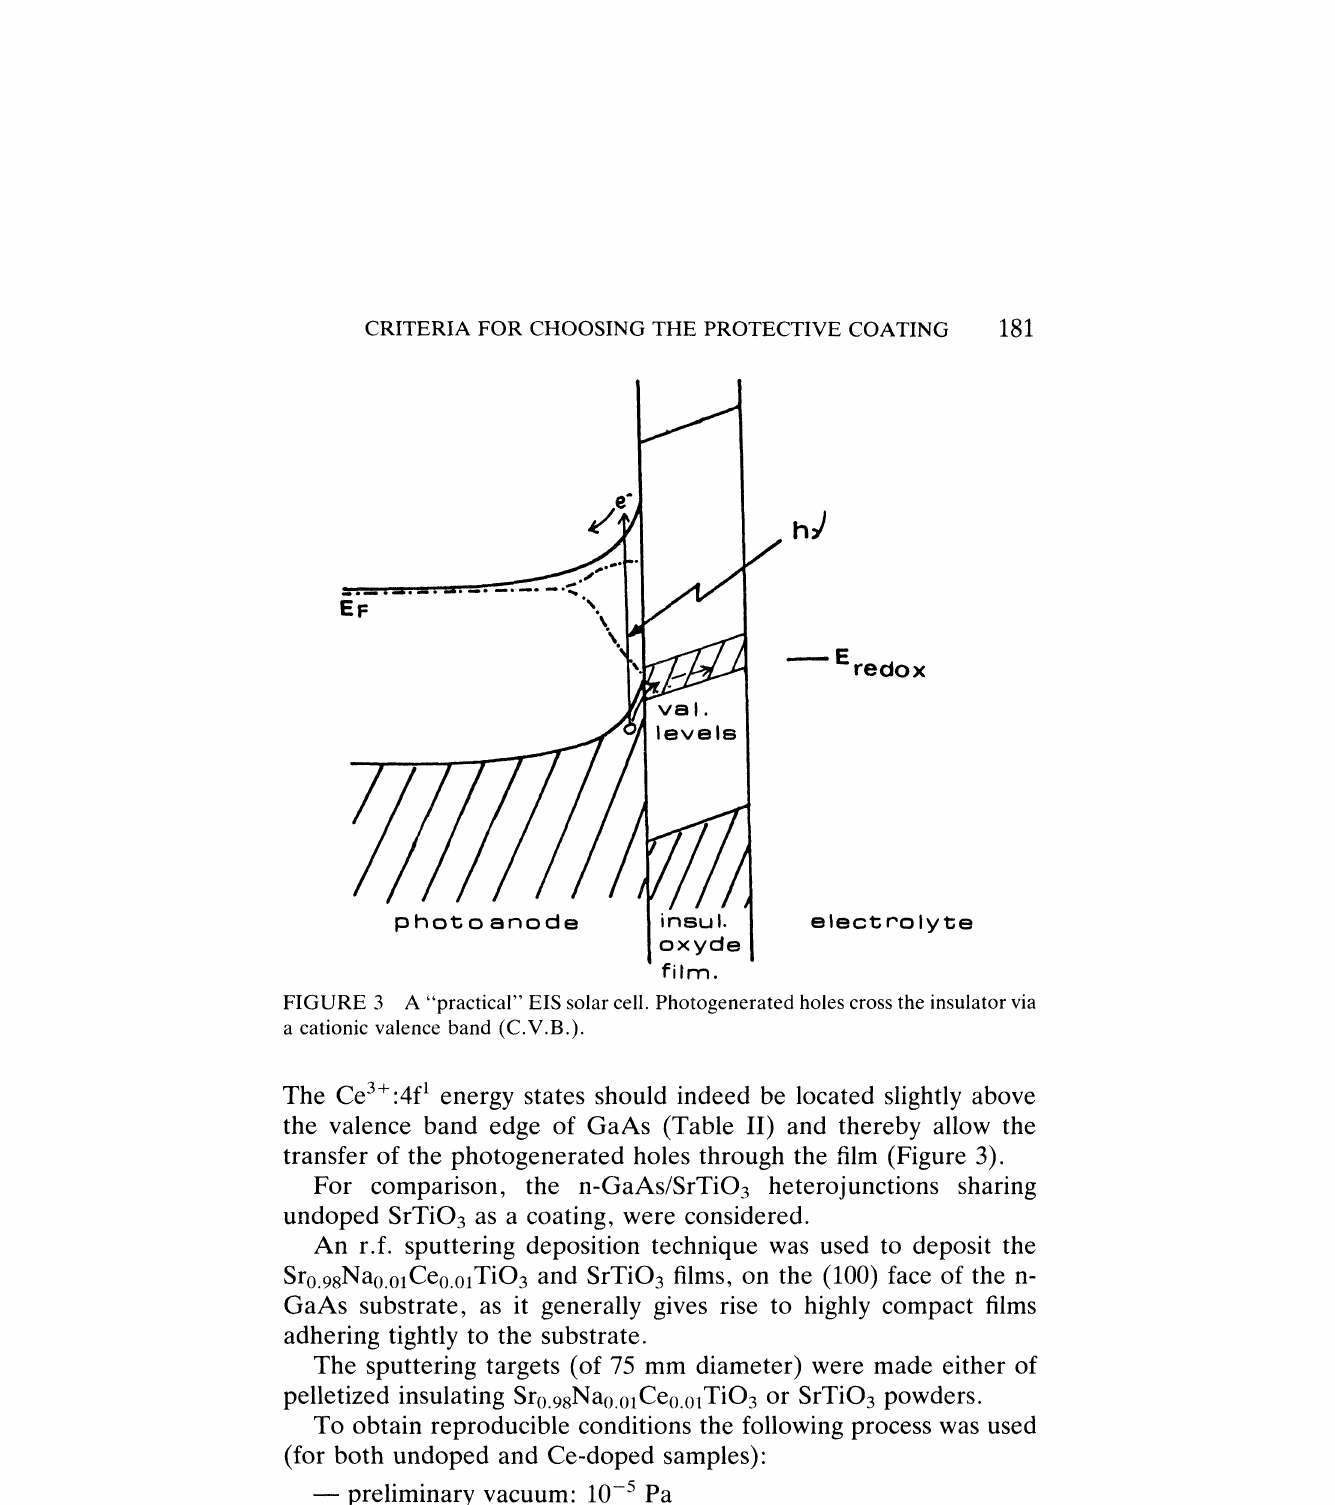
FIGURE 3 A "practical" EIS solar cell. Photogenerated holes cross the insulator via a cationic valence band